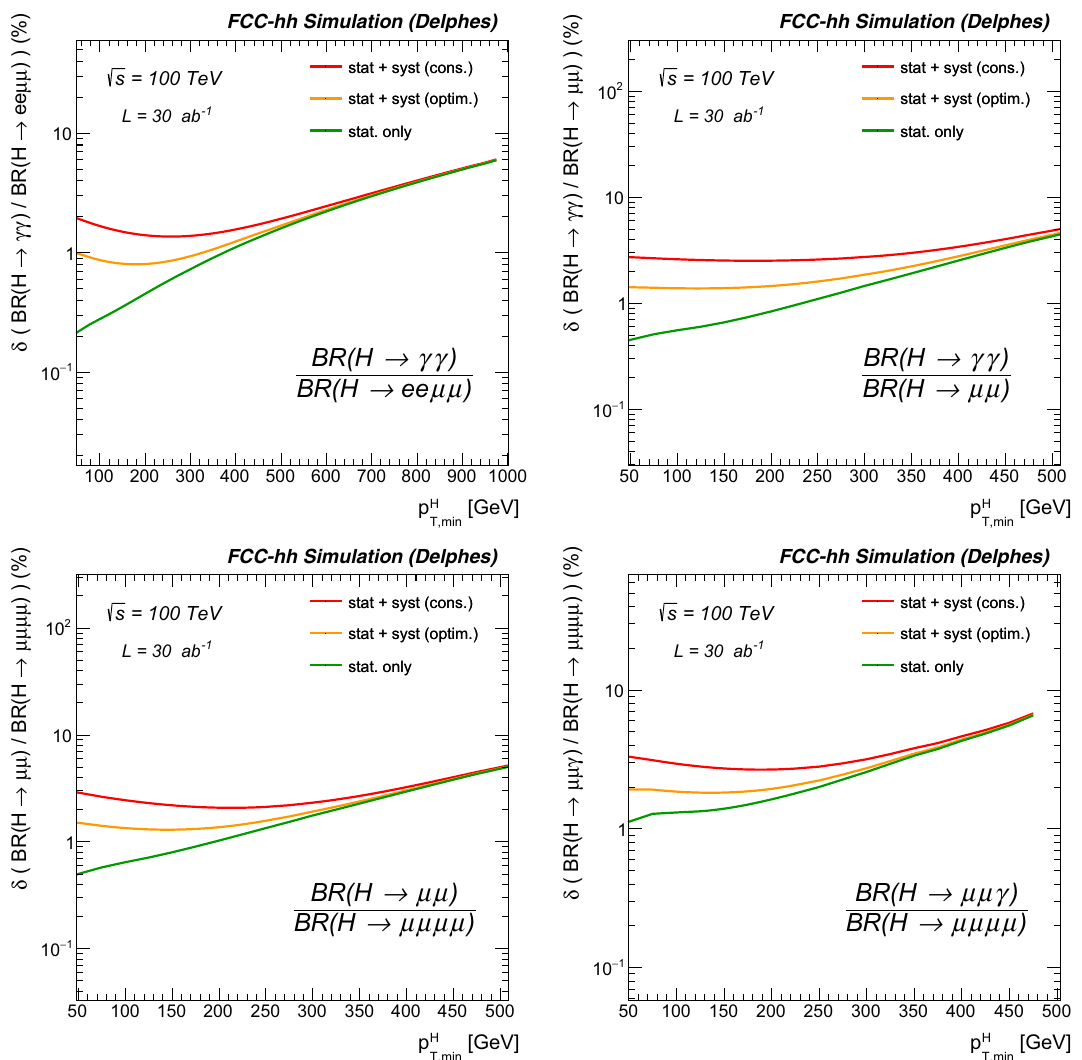
Fig. 4.6 Projected precision for the measurement of ratios of rates of different Higgs final states, in the gg → H production channel. The systematic uncertainty labels are defined in the text ± ± studies, is documented in Ref. [88]. The extraction of the W W signal requires the removal of large QCD backgrounds L L (W ± W ± + jets, WZ + jets) and the separation of large EW background of transverse-boson scattering. The former is suppressed by requiring a large dilepton invariant mass and the presence of two jets at large forward and backward rapidities. The longitudinal component is then extracted from the scattering of transverse states by exploiting the different azimuthal correlations between the two leptons. The precision obtained for the measurement of the W L W L cross section as a function of integrated luminosity, is shown in Fig. 4.9 (left). The three curves correspond to different assumptions about the rapidity acceptance of the detector and drive the choice of the detector design, setting a lepton (jet) acceptance out to | η | = 4 ( 6 ) . The small change in precision when increasing the jet cut from p T > 30 to p T > 50 GeV indicates a strong resilience of the results against the presence of large pile-up. The quoted precision, reaching the value of 3% at 30ab − 1 , accounts for the systematic uncertainties of luminosity (1%), lepton efficiency (0.5%), PDF (1%) and the shape of the distributions used in the fit (10%). The right plot in Fig. 4.9 shows the impact of rescaling the WWH coupling by a factor κ W . The effect is largest at the highest dilepton invariant masses, as expected. The measurement precision, represented by the small vertical bars, indicates a sensitivity to δκ W at the percent level, as shown also in Table